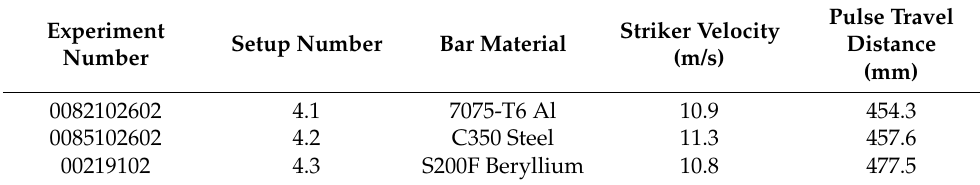
Table 3. A summary of the experimental conditions for all Kolsky bar experiments conducted in the present